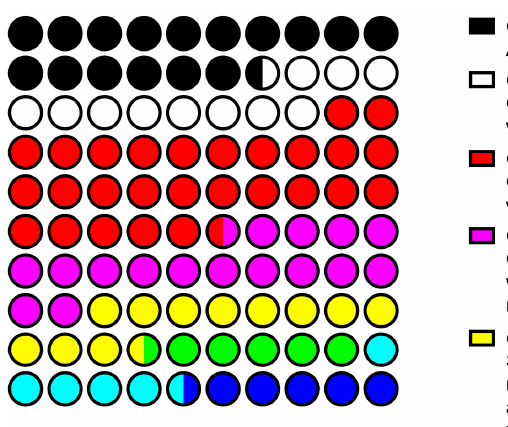
Figure 2. Contingency of personal CTCs profile in breast ‐ cancer patients. Interpersonal heterogeneity characterized with various combinations of CTCs with and without stemlike and/or EMT features. Eight patient groups with a combination of various CTC phenotypes presented.